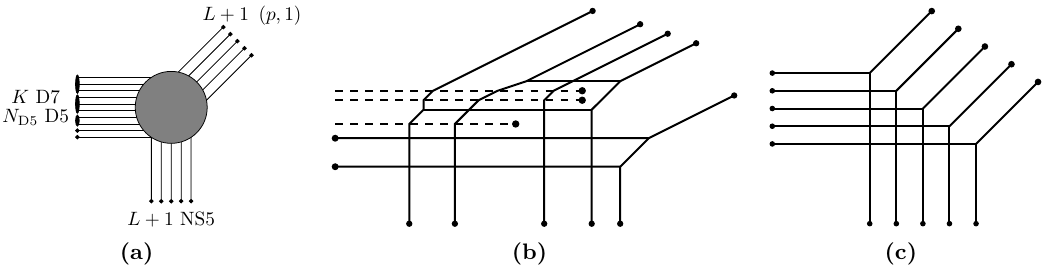
Figure 3 . Left: junction of L + 1 NS5-branes, L + 1 ( p, 1) 5-branes, and N on K D7-branes as specified by ρ in (6.4). Center: gauge theory for ρ = [3 2 , 2 , 1 2 ] and p = 2 , after moving D7-branes into the web (the dashed lines show the branch cuts). Right: 5d T N theory, corresponding to ρ = [1 N ]